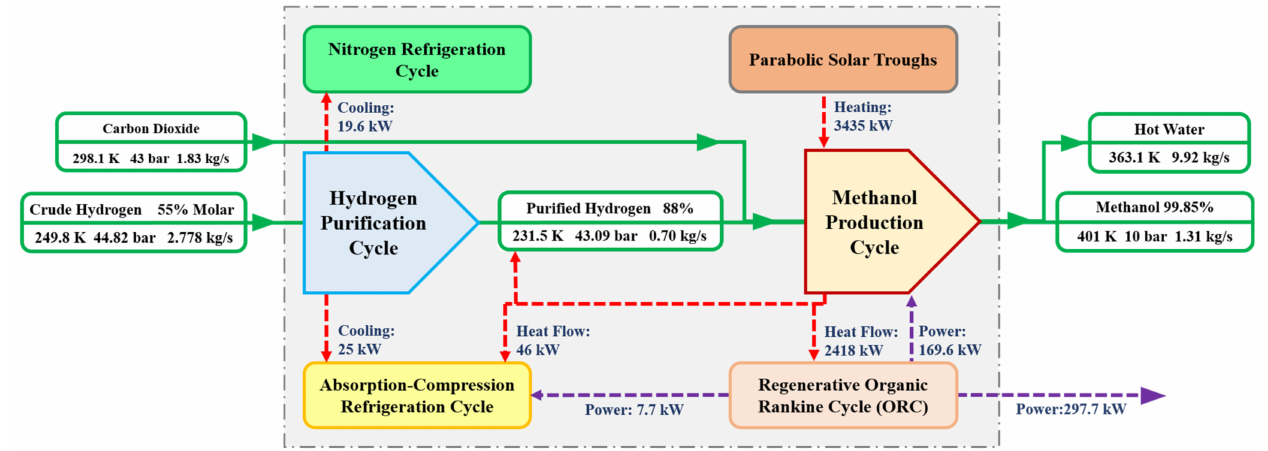
Figure 1. The block flow diagram (BFD) of the integrated